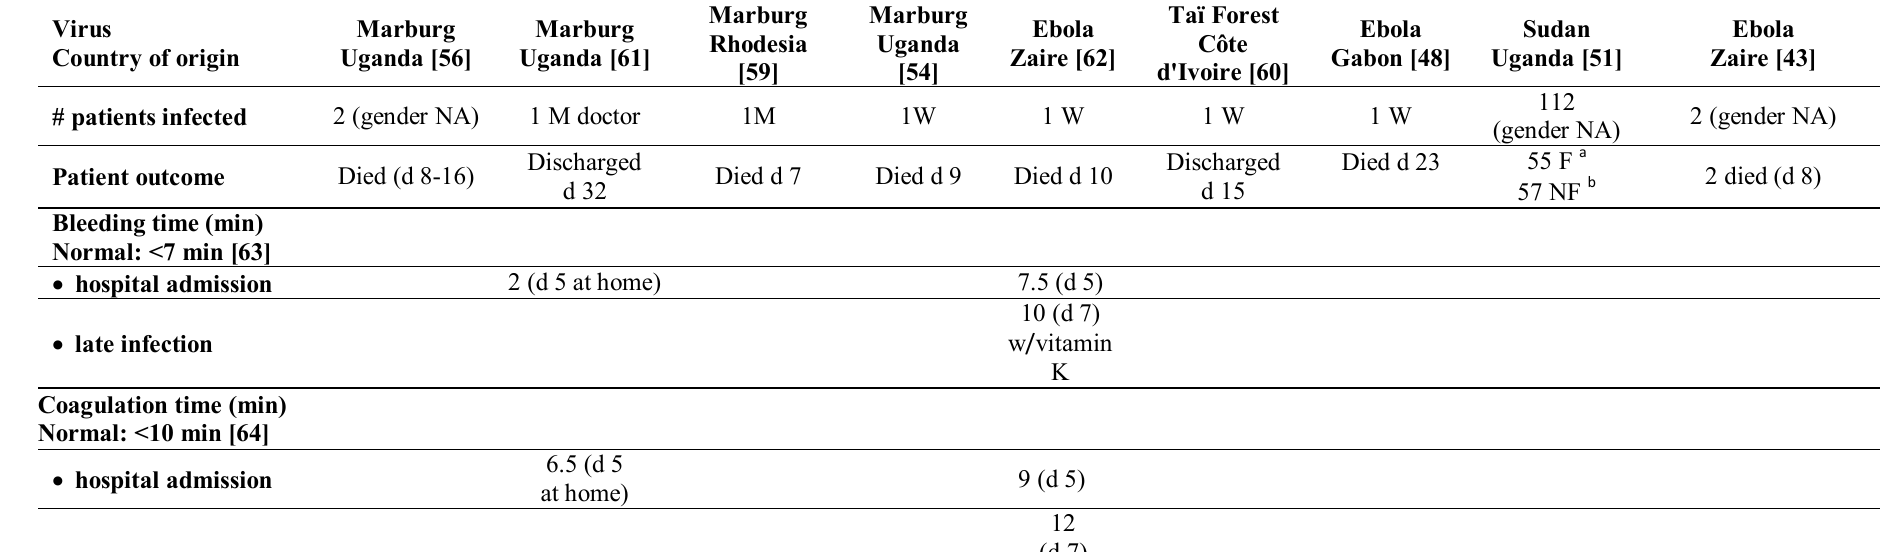
Table 1 . Coagulation Parameters in Humans with Filovirus Infections.